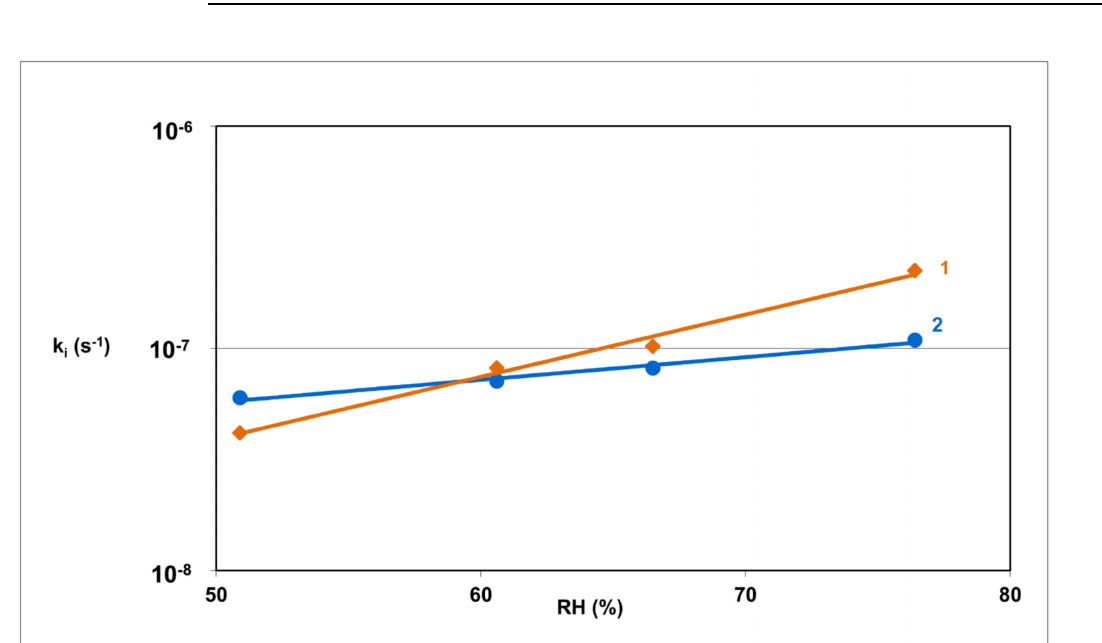
Figure 4. Semi-logarithmic plots of the degradation rate constant of pure RAM and RAM in the presence of HPMC as a function of RH% under T = 343 K (1: pure RAM, 2: